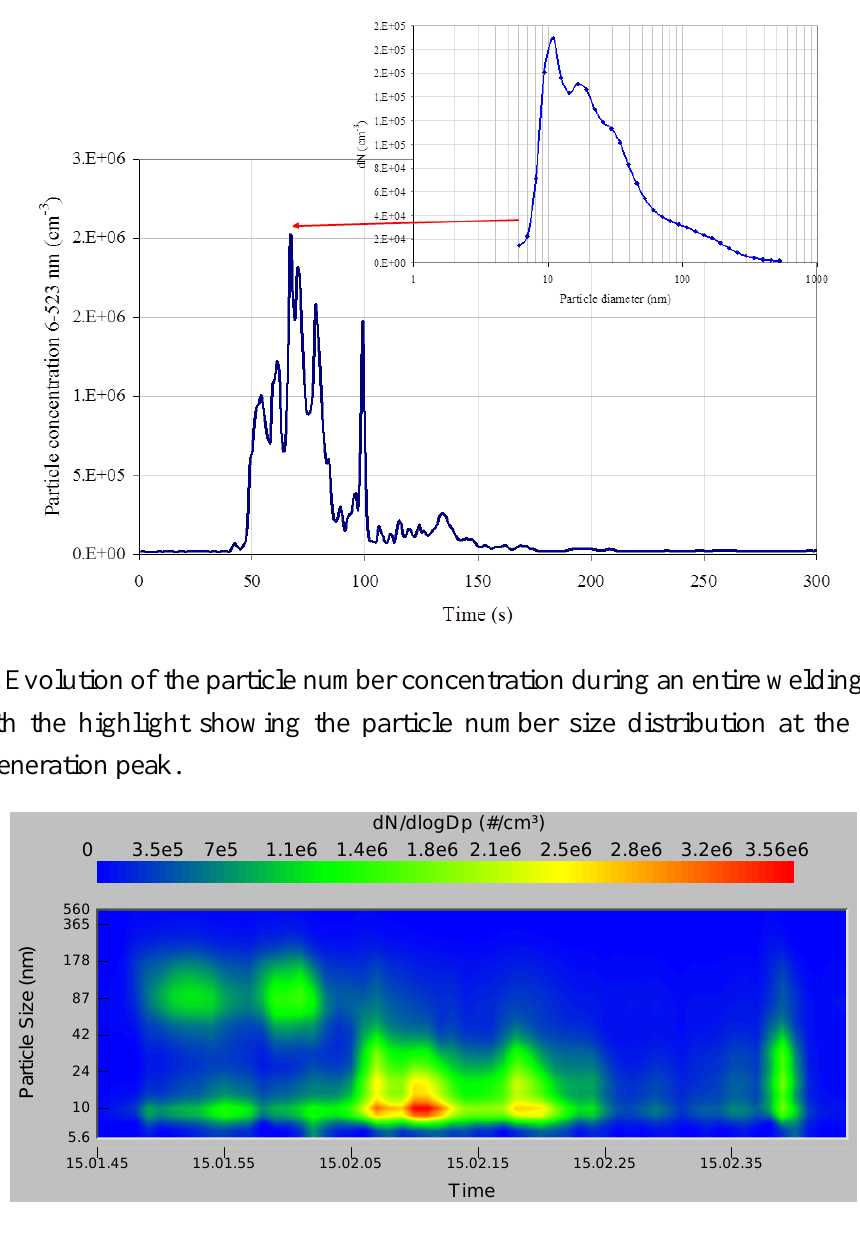
Figure 6. Dimensional distribution showing the rapid temporal evolution of particles during welding operations (Fast Mobility Particle Sizer software, release version 3.1.0.0, TSI, Shoreview, MN,